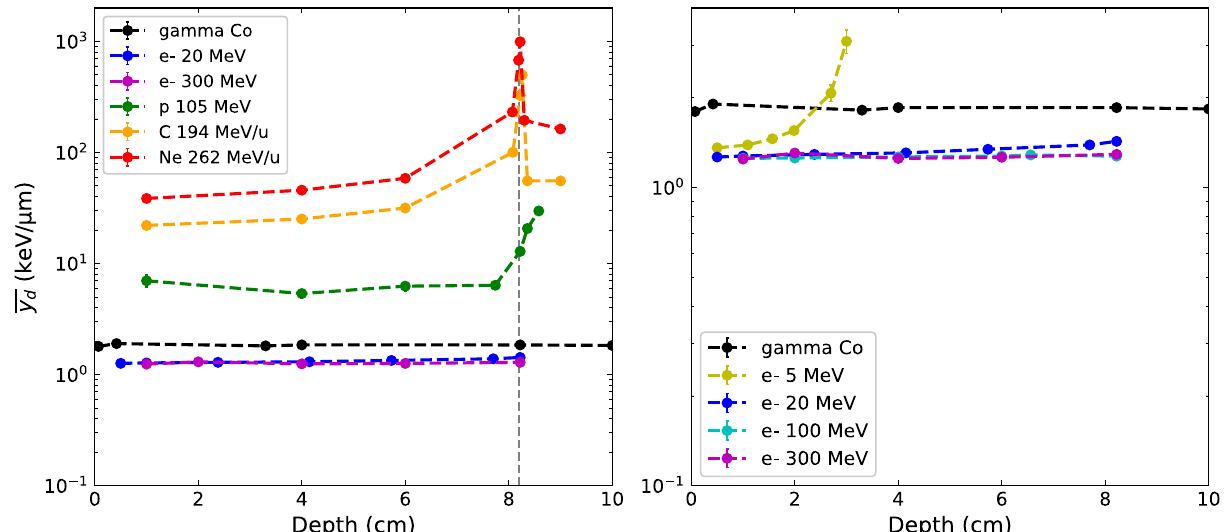
Figure 6. Dose-mean lineal energy profiles y d in depth to water for photon, clinical electrons, VHEE and ion beams (left), and details of the y d values for all electron energies (right). The vertical grey dashed line marks the Bragg peak